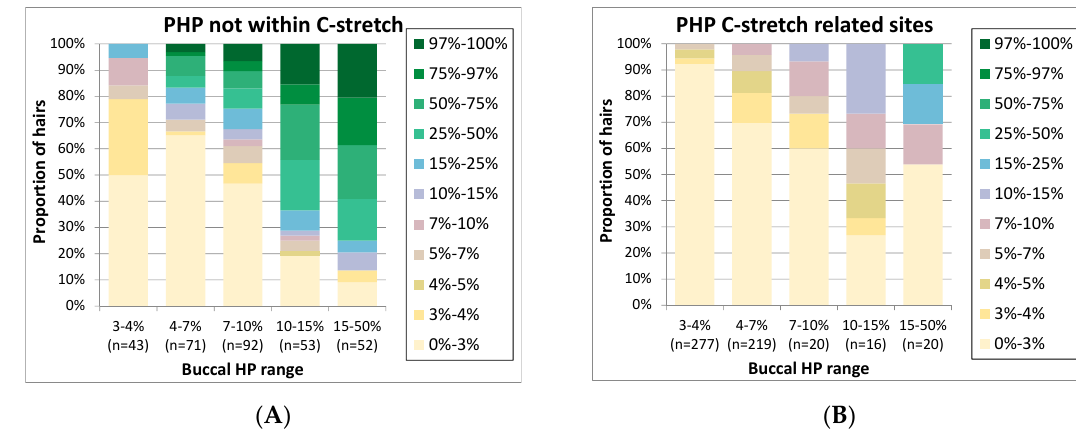
Figure 4. For point heteroplasmy (PHP) events observed in buccal references (grouped in PHP level categories on the x -axis), the proportion of hairs in various PHP level categories (see colour coding) is displayed (total number of investigated occurrences in hairs is indicated as n on the x -axis). The figure is divided in ( A ). Data for positions located within, or directly adjacent to, C-stretches are displayed separately ( B ) from non-C-stretch-related positions ( A ).